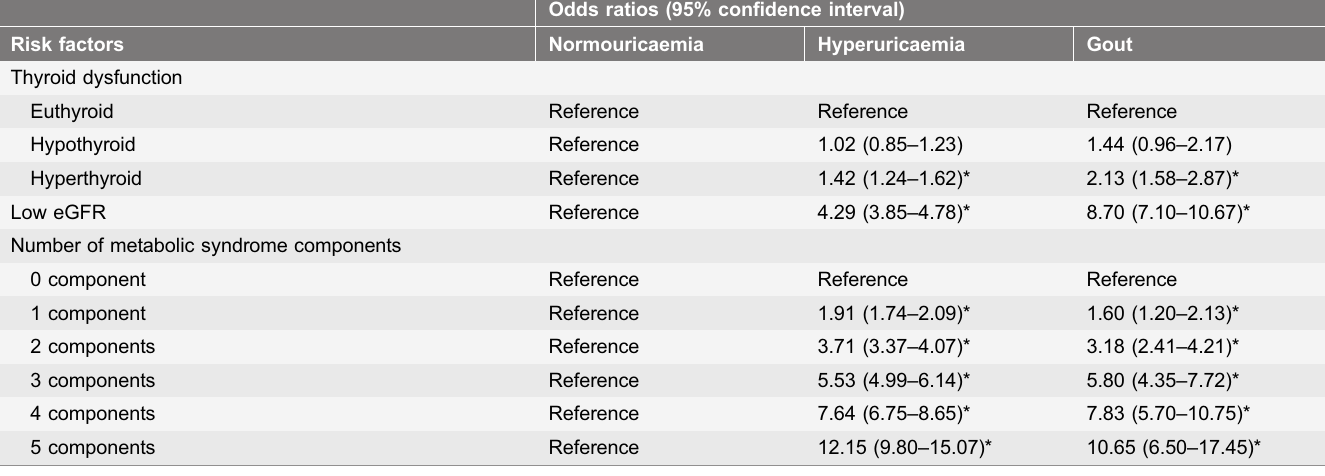
Table 3. Age- and multivariate-adjusted relative risks of hyperuricaemia and gout in women with euthyroid, hypothyroid, and hyperthyroid status. Odds ratios (95% confidence